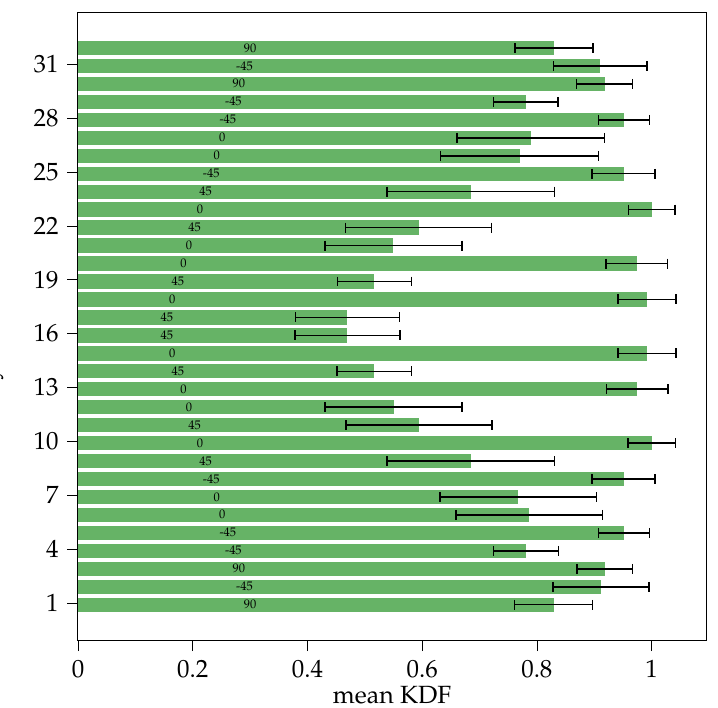
Figure 11. Distribution of mean of KDF for R x within the selected laminate configuration with related variances as second bar element of the stochastic results. For each layer, the ply angle is additionally